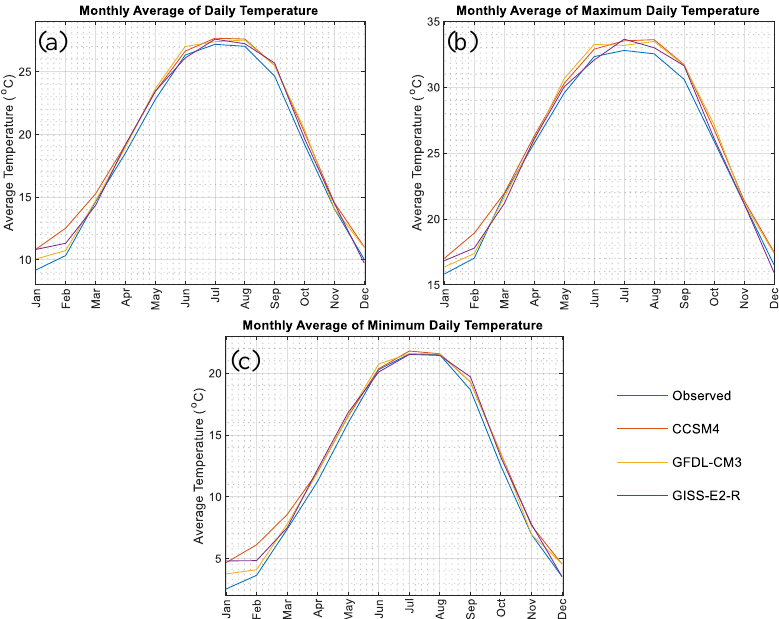
Figure 4. Comparing average, maximum, and minimum temperatures between models and observed data.